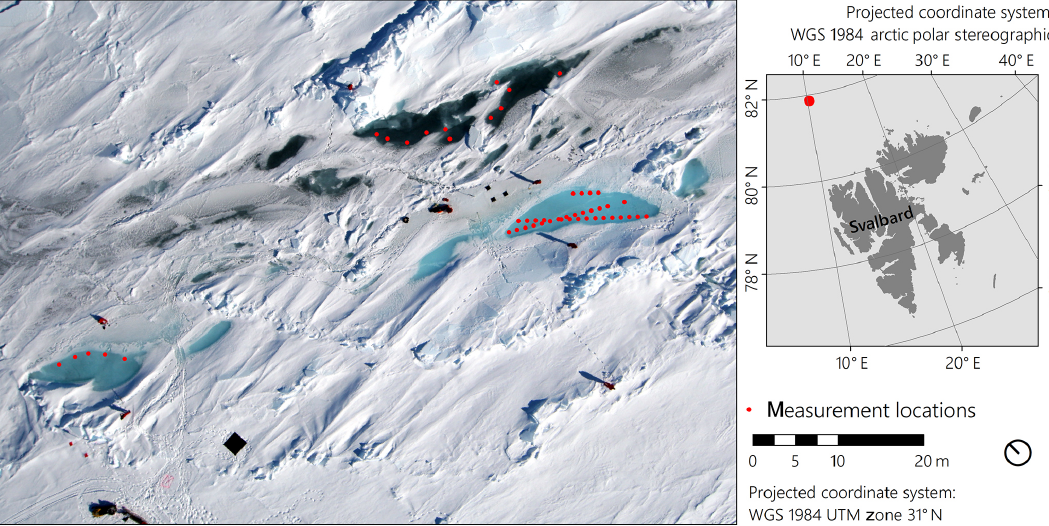
Figure 3. Overview of measurement sites in the three ponds. Aerial photo: Gerit